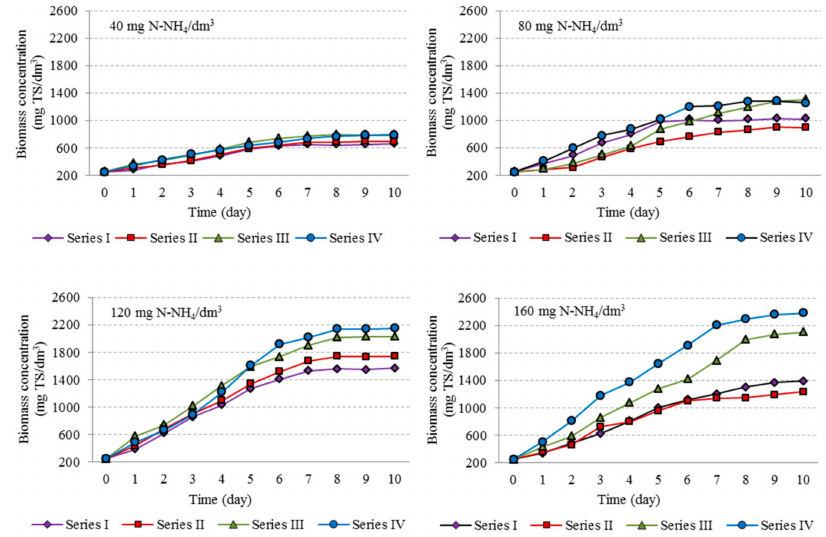
Figure 1. The biomass concentration of Chlorella vulgaris depending on the variants and series of the